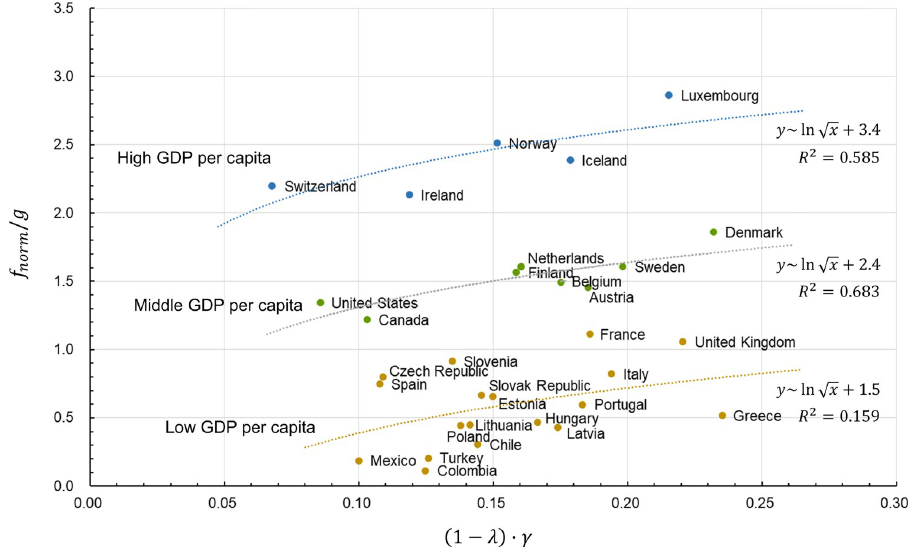
Fig 7. Relationship between λ , γ , f norm , and g of OECD member countries. The horizontal axis shows (1 − λ ) � γ of the saving rate λ and the surplus contribution rate γ of the wealthy, and the vertical axis is f norm = and the Gini index g , of countries from the Organisation for Economic Co-operation and Development (OECD). The blue, green, and brown plots show the groups of high, middle, and low GDP per capita, respectively. The high and middle GDP per capita groups fit well in the regression equations with high coefficients of determination R 2 , but the low GDP per capita group has low R 2 because the regression equation was applied to all the remaining countries except the high and middle